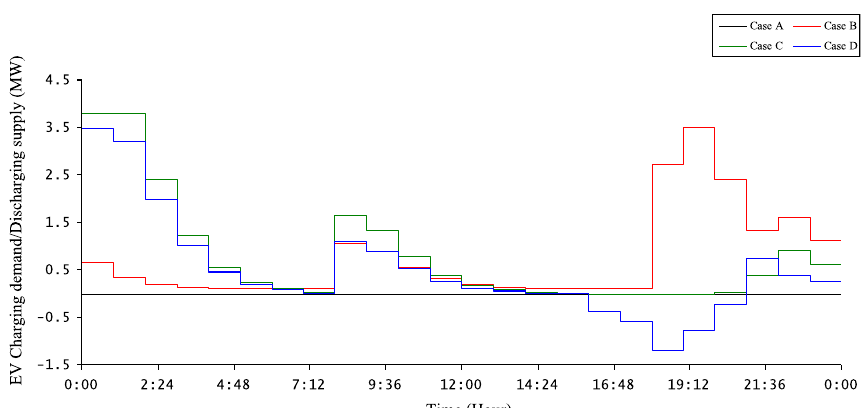
Fig. 8 Hourly charging demands/discharging supplies of EVs under four cases (Positive power denotes the charging demand of EVs. Negative power expresses the discharging supply of EVs)